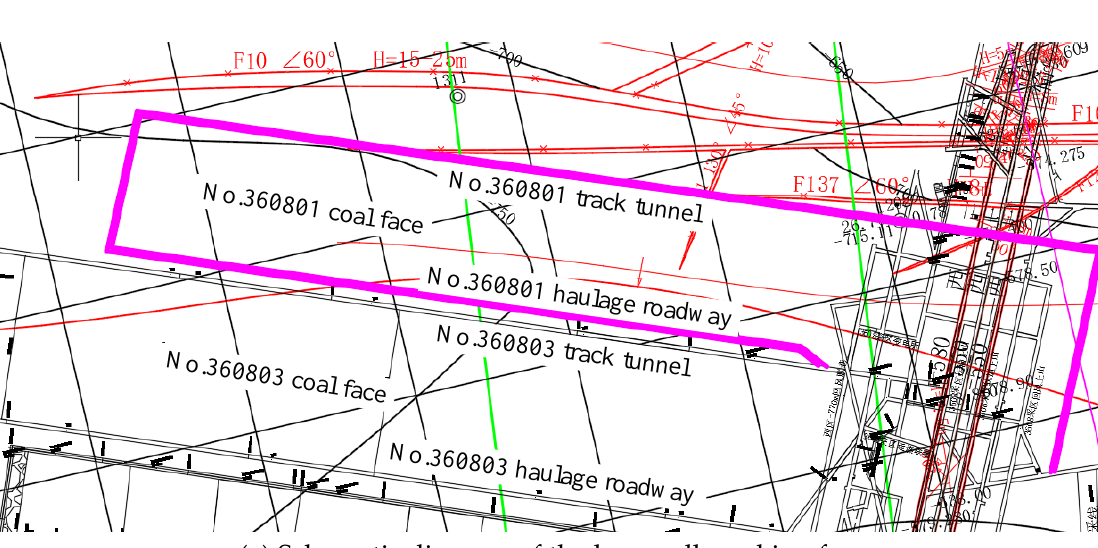
Figure 1. Nappe structure plane diagram.